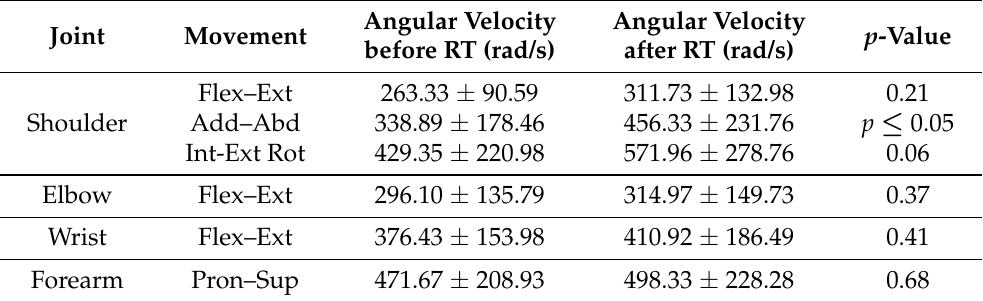
Table 14. Angular velocities obtained for the paretic limb in the Apley Scratching Test before and after the rehabilitation therapy.